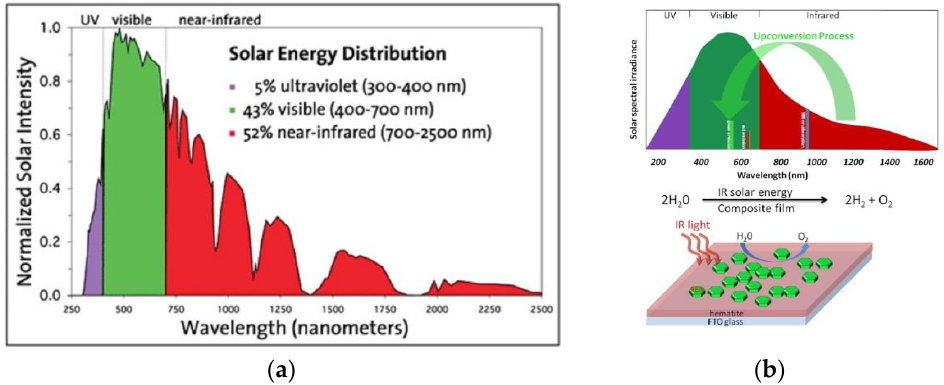
Figure 4. ( a ) Solar energy distribution and capture by a semiconductor photoabsorber; ( b ) mechanism of the up-conversion process (top) and enhanced solar water splitting performance by using near infrared radiation with the aid of rare earth materials (bottom). Reprinted from Reference [44].